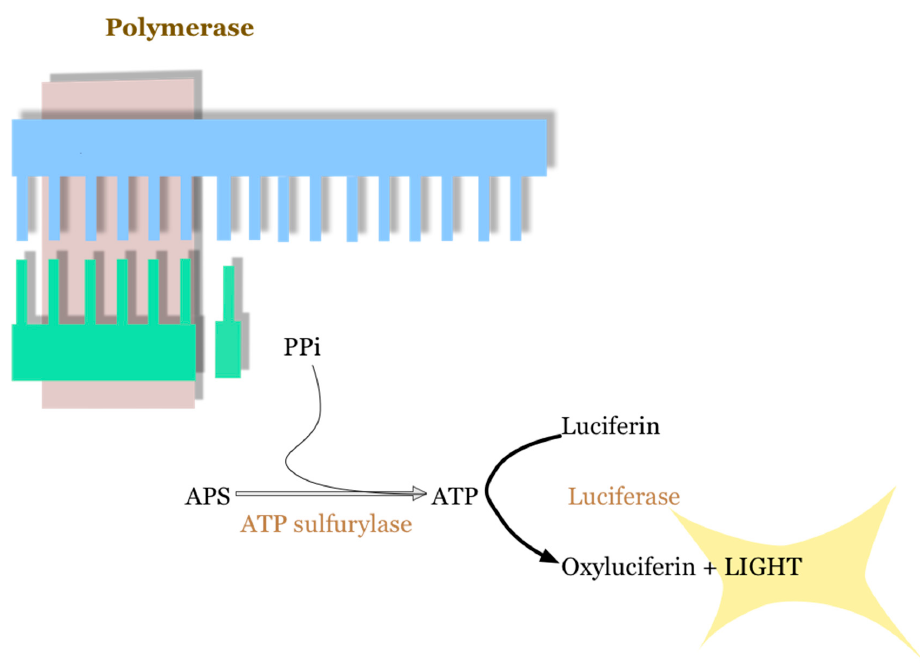
Figure 6. The transformation reaction of luciferin to oxyluciferin, with light release. ATP is generated by ATP sulfurylase from adenosine 5'phosphate (APS), in the presence of pyrophosphate, which is used as a cofactor.